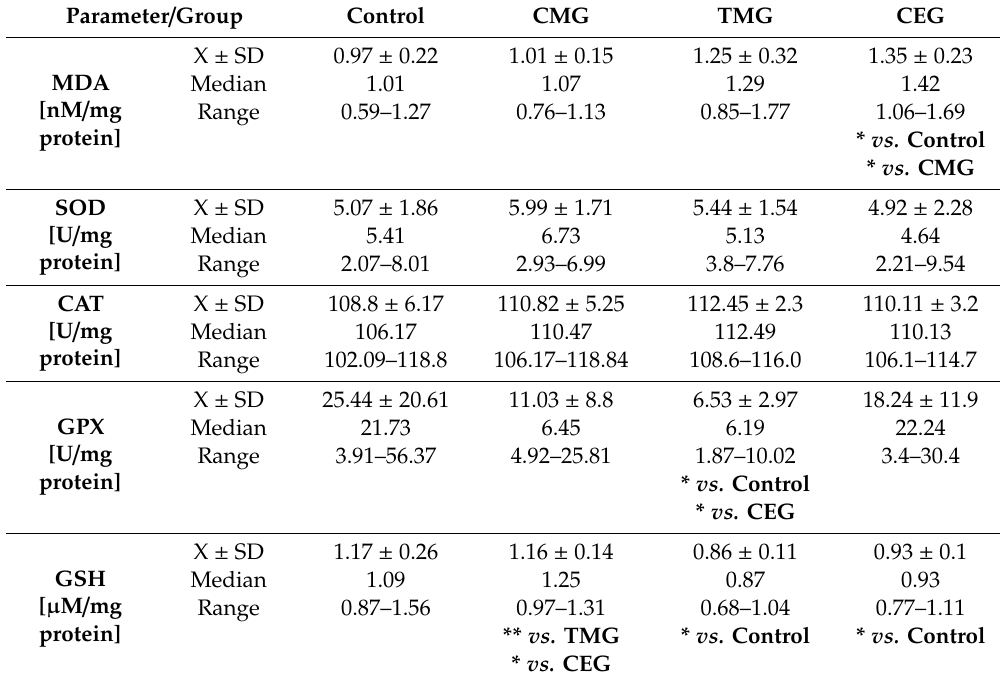
Table 3. MDA concentration, SOD, CAT, and GPX activity, and GSH concentration in the hepatic tissue of female rats of the control, CMG, TMG, and CEG